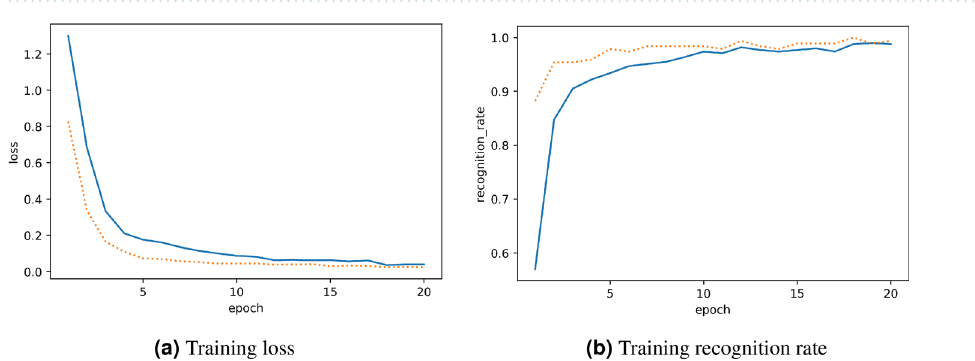
Figure 4. Interaction terms (non-diagonal elements) and biases (diagonal ones). The left-hand side panel shows the result of the trained model by the direct sampling from the quantum annealer, the center one is that by the MCMC in short equilibration time and sampling period, and the right-hand side one is that by MCMC in long equilibration time and sampling period.